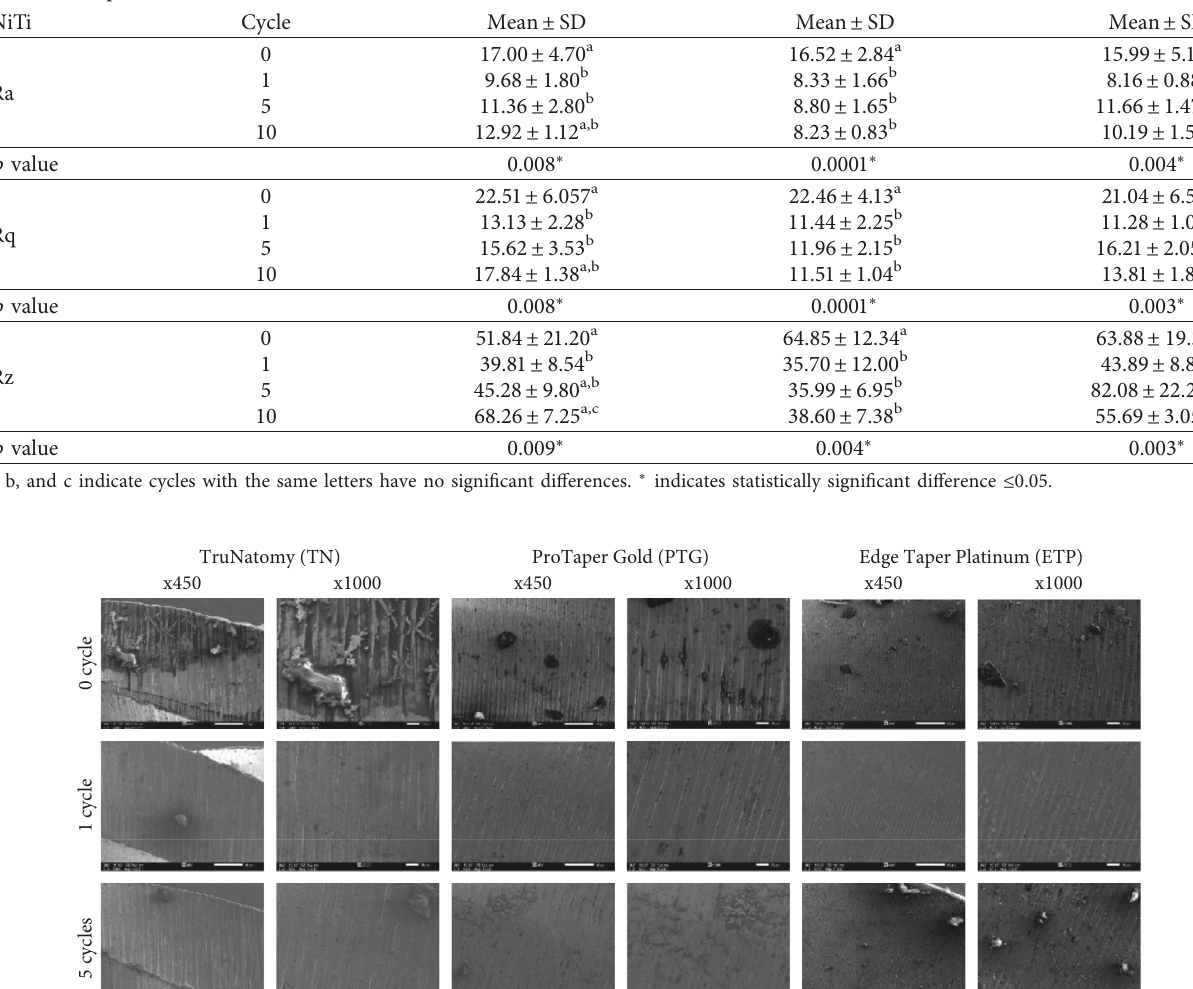
Table 1: Mean and standard deviations of SR parameters before and after different autoclaving cycles. SR parameters